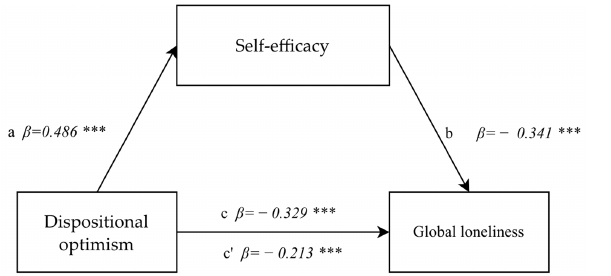
Figure 2. The model of a mediatory role of self-efficacy between dispositional optimism and global loneliness. Statistically significant: *** p < 0.001 loneliness. Statistically significant: *** p < 0.001.